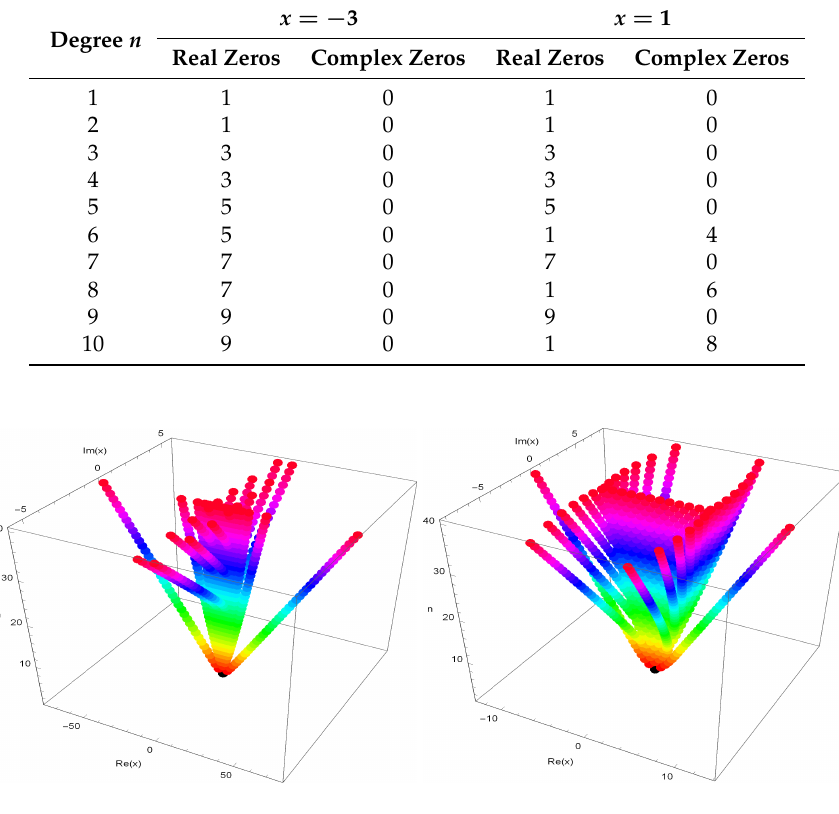
Figure 3. Stacks of zeros of E